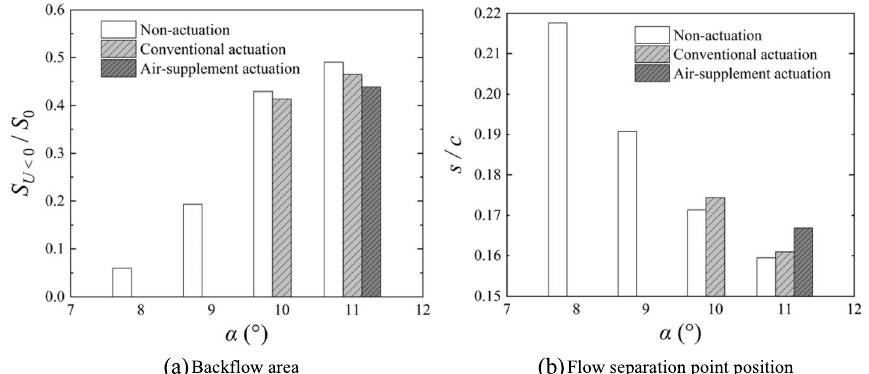
Fig. 8 Flow separation characteristic parameter variation according to the attack angle under different actuation